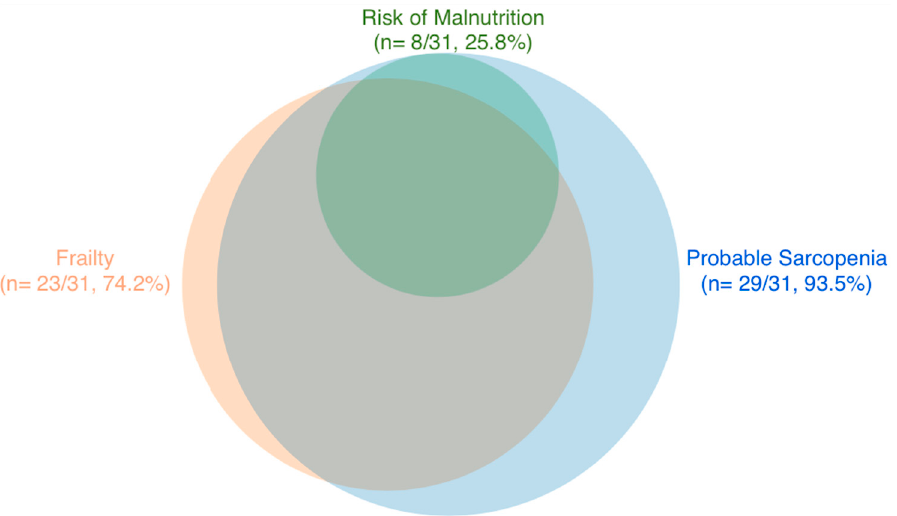
Figure 2. Venn diagram of overlap between probable sarcopenia, frailty and risk of malnutrition in dependant older adults ( n = 31) .